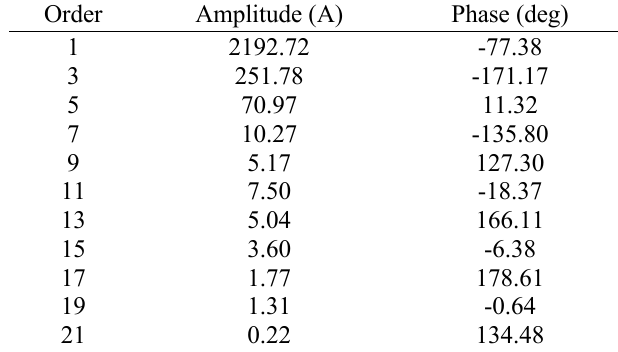
Table 7: Harmonics of phase 'a' Current for case study motor